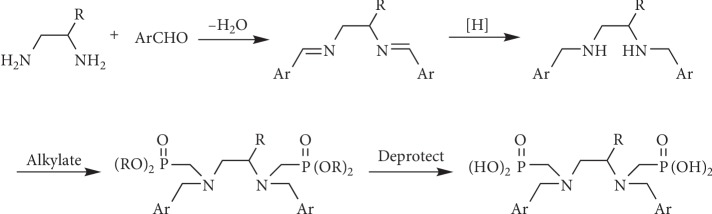
General synthetic scheme for HBEDP analogs 3, 4, and 5.